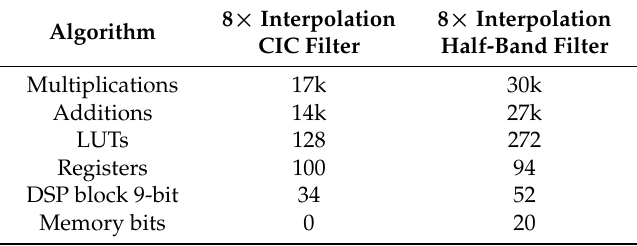
Table 2. Performances of the 8 × interpolation CIC filter and 8 × interpolation half-band filter. 8 × Interpolation 8 × Interpolation Algorithm CIC Filter Half-Band